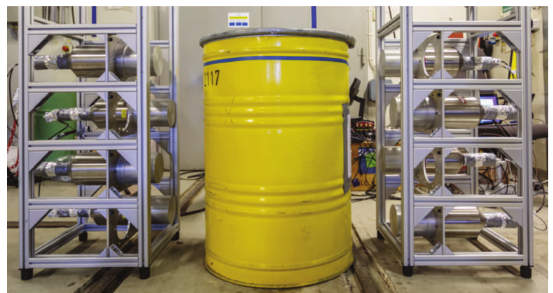
Fig. 8. Set-up used in the test measurements on legacy waste at AB SVAFO. Photo by Fredrik